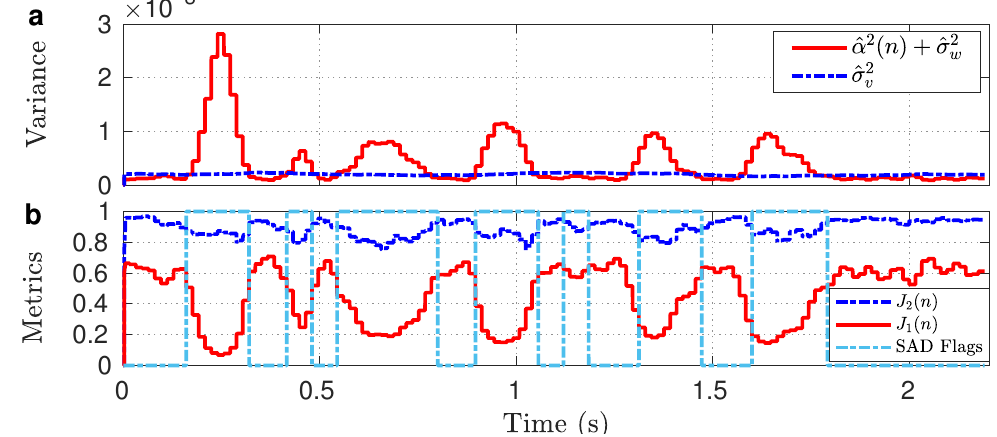
Figure 4. Comparing the estimated: ( a ) [ ˆ α 2 ( n ) + ˆ σ 2 w ] , ˆ σ 2 v and ( b ) J 2 ( n ) , J 1 ( n ) metrics from the noisy speech in Figure 2c.